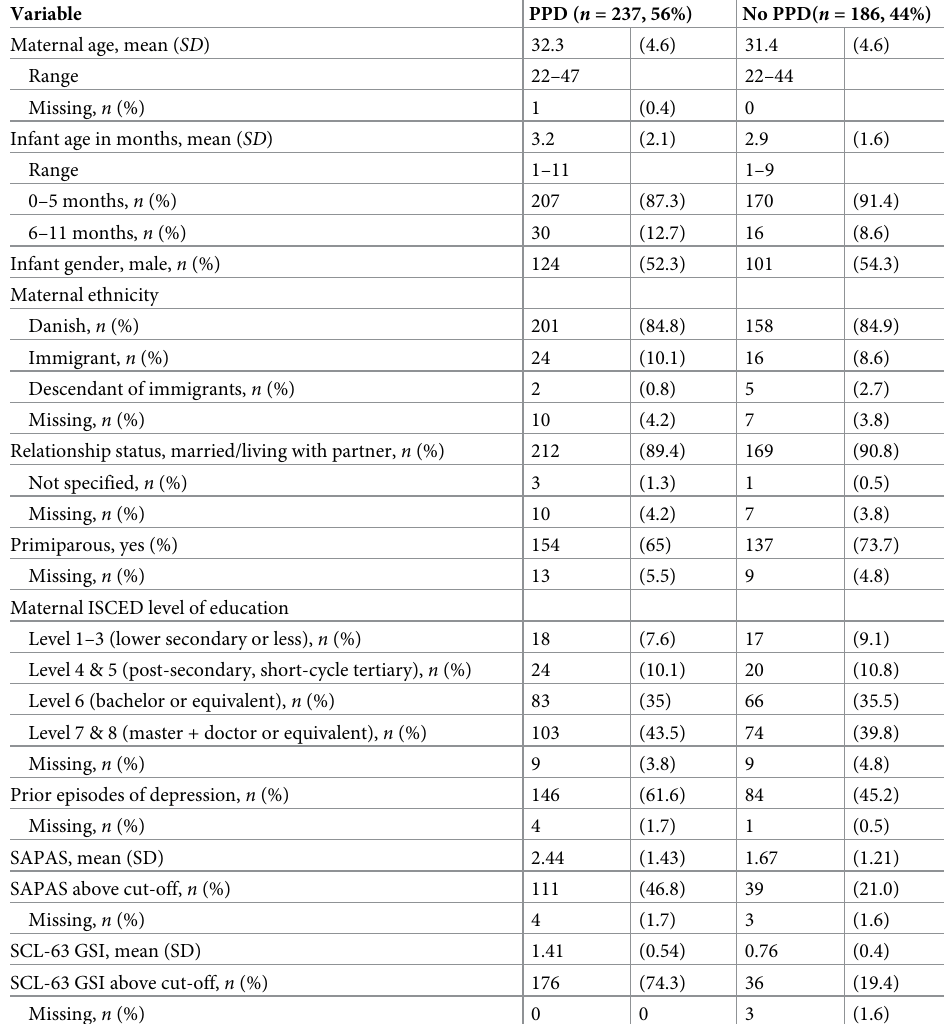
Table 1. Sample characteristics (n =